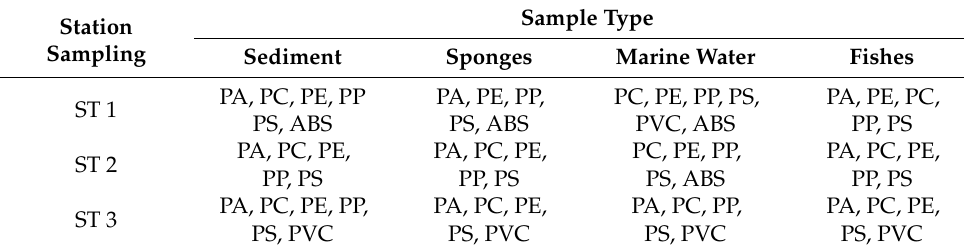
Table 3. Type and distribution of MP pollutants in each